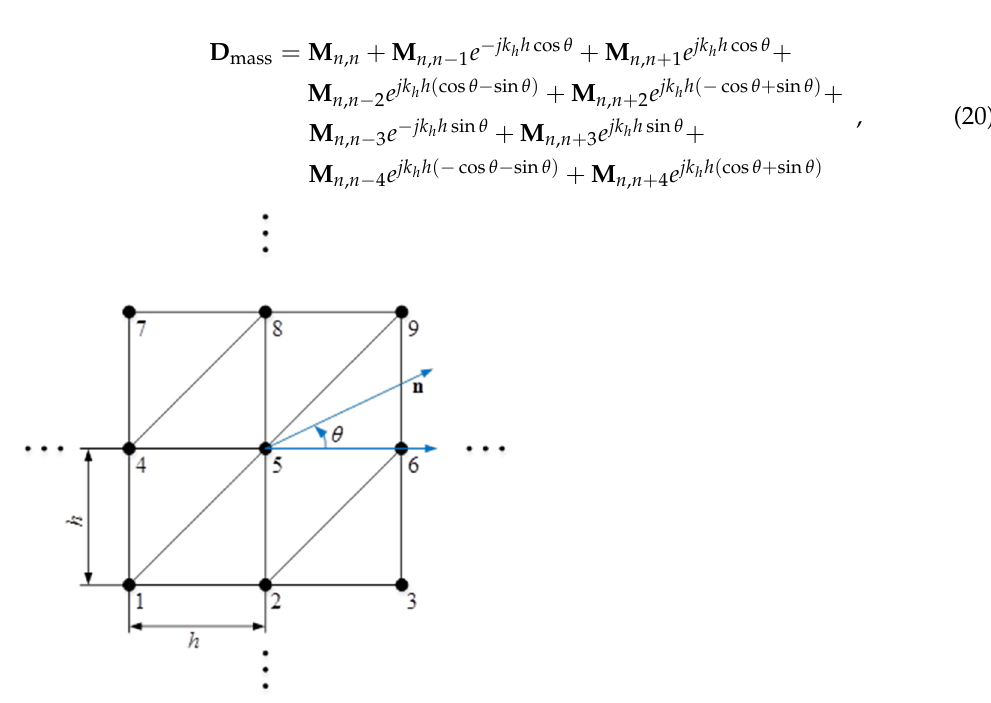
Figure 1. The uniform triangular mesh in the analysis of the numerical dispersion.